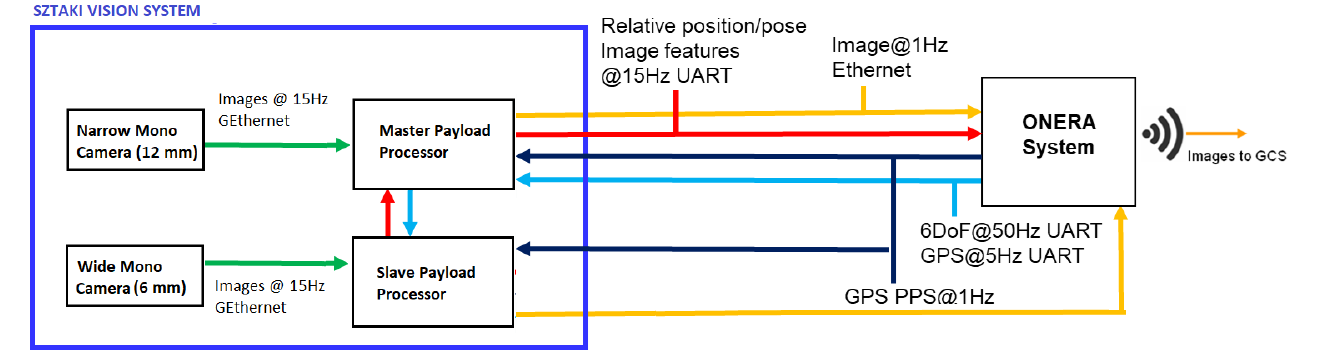
Figure 8. Components and interfaces of the monocular vision sensor with two cameras and two payload computers.